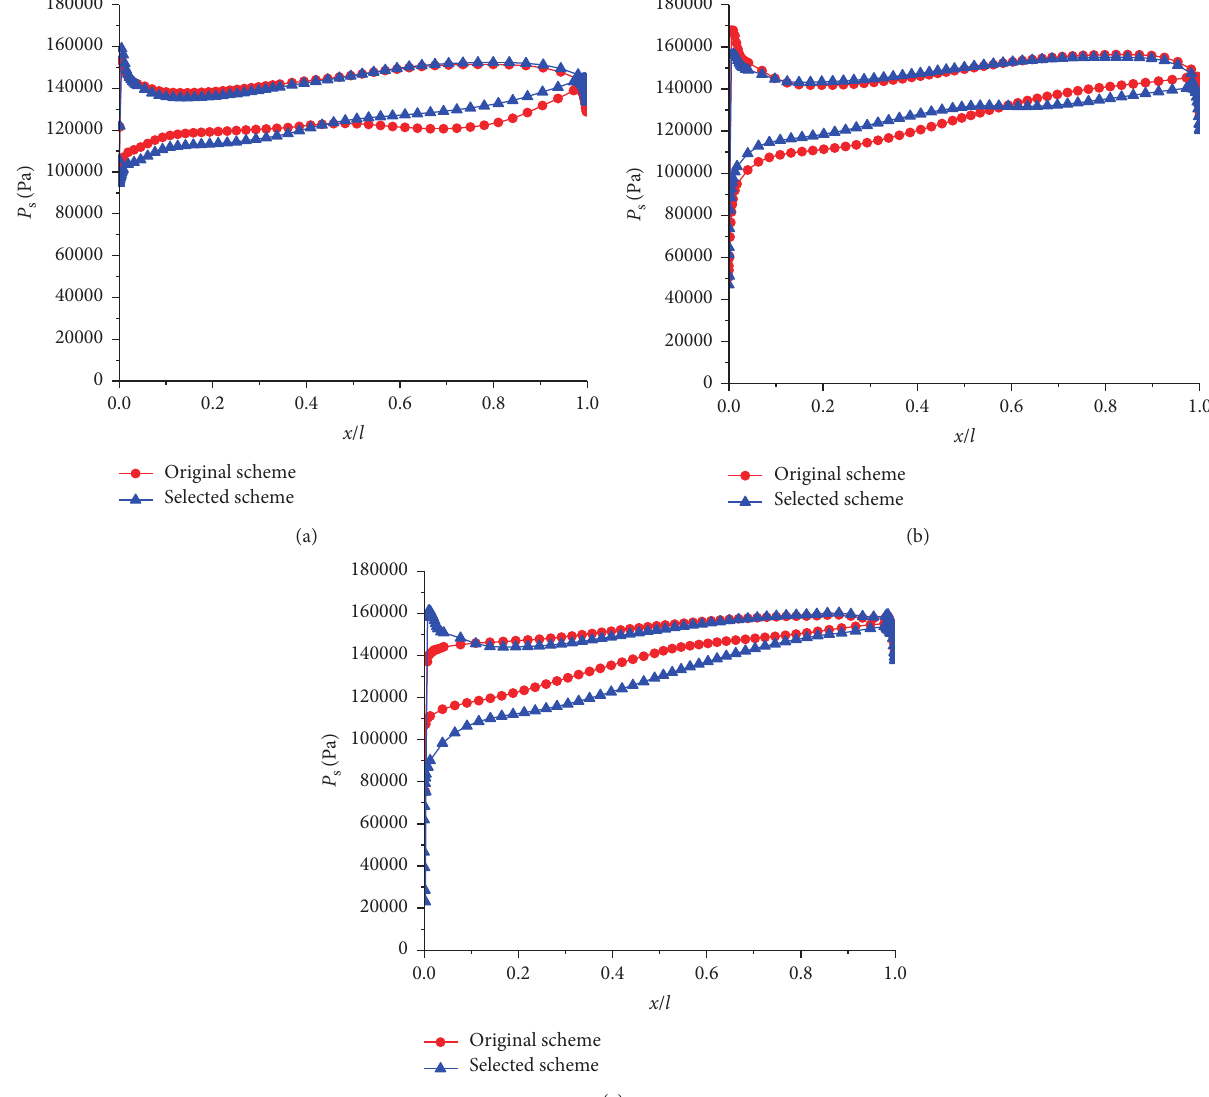
Figure 14: Static pressure distribution on each span under 0.5 Q ′ condition: (a) span � 0.1; (b) span � 0.65; (c) span �